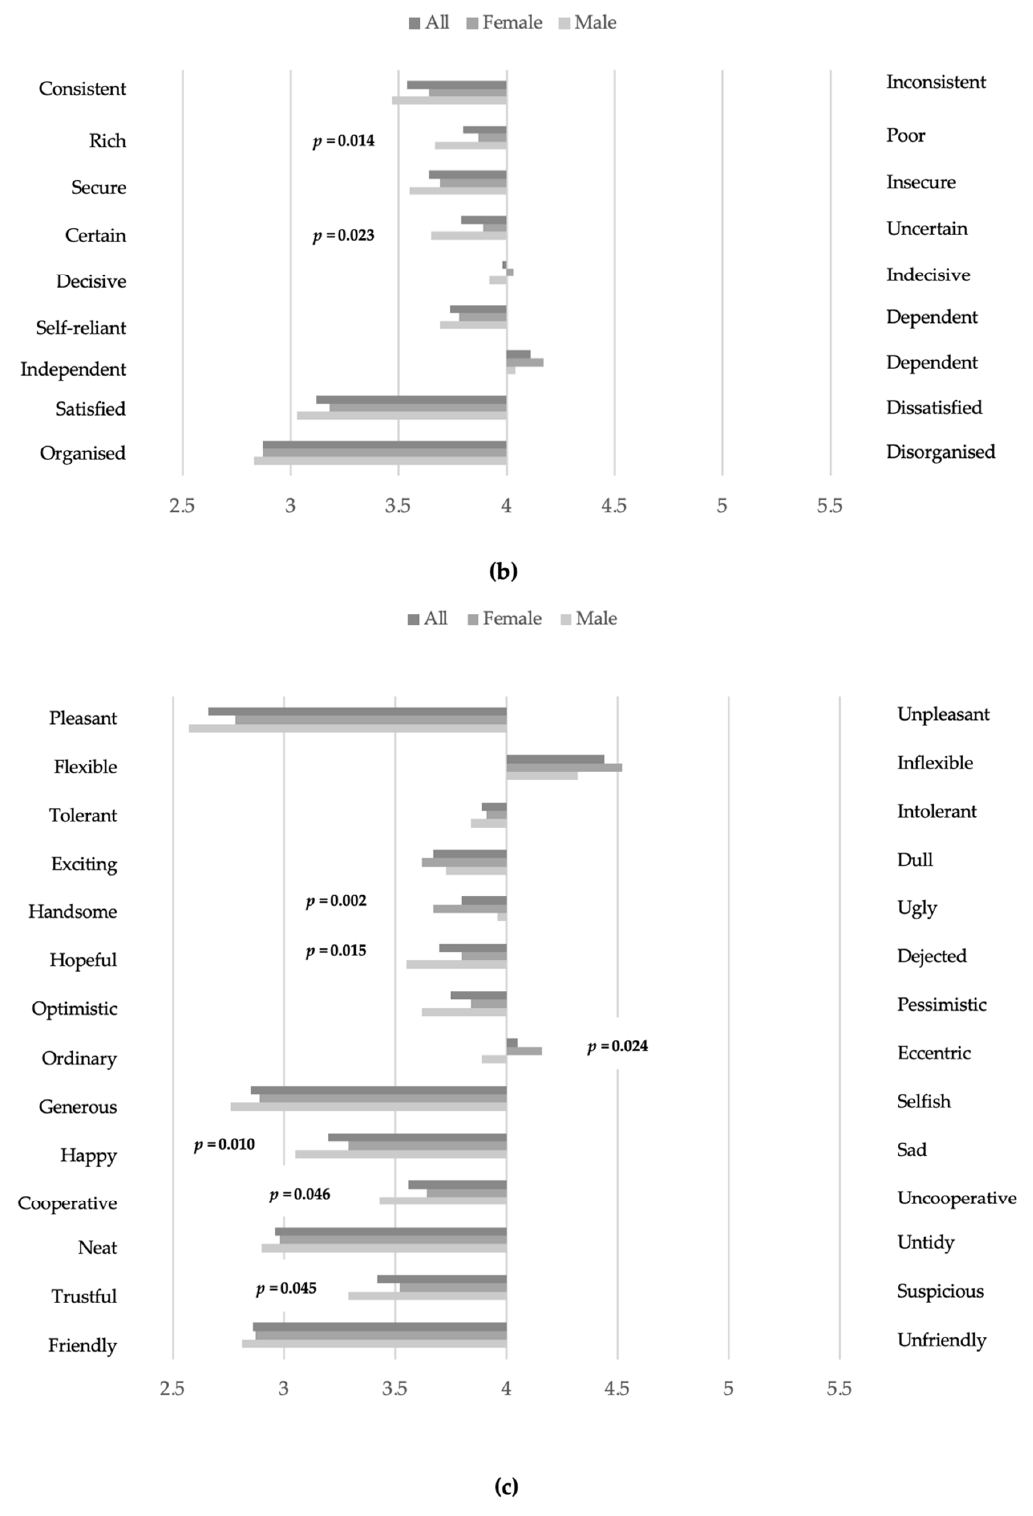
Figure 1. Assessment of student attitudes (mean scores, 4 = neutral attitude, the lower the score the more positive the attitude) towards seniors in the three dimensions “instrumental–ineffective”, “autonomous–dependent”, and “personal acceptability–unacceptability”. (Mann–Whitney U test, p ≤ 0.05). ( a ) instrumental–ineffective; ( b ) autonomous–dependent; ( c ) personal acceptability–